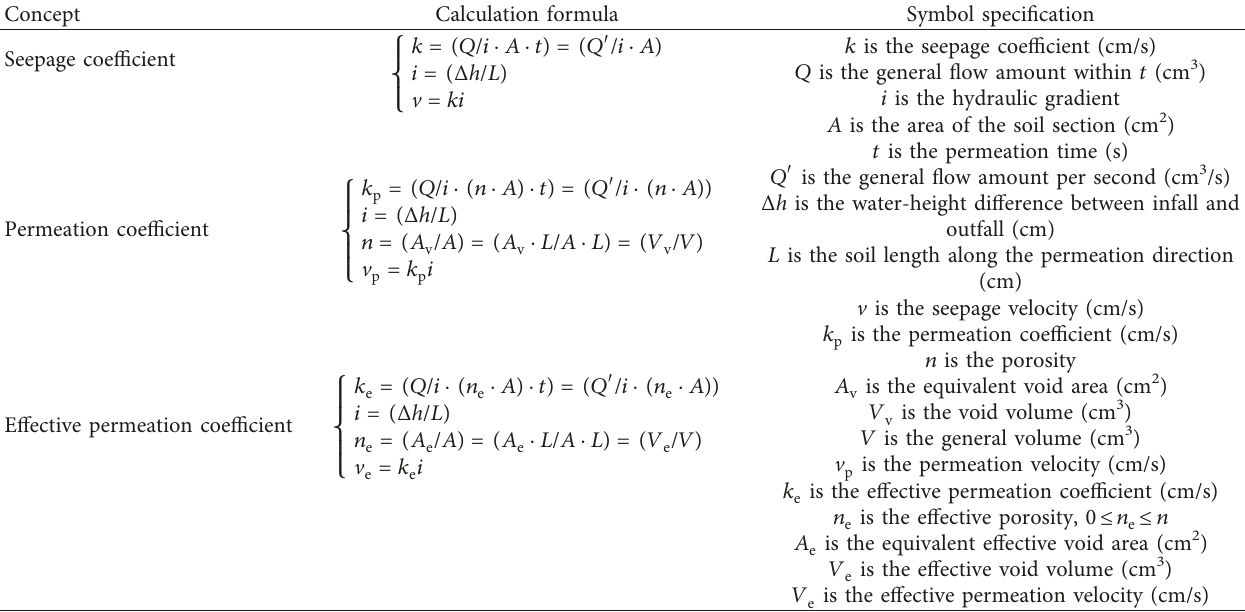
Table 2: Calculation formulas of the permeability coefficient for different concepts.